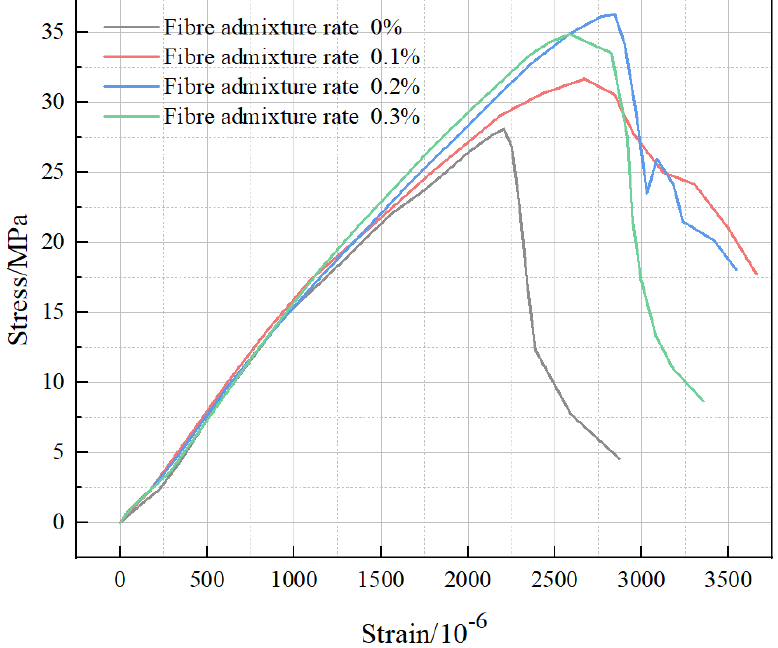
Figure 11. Effect of fiber admixture on BFRC stress–strain curves (freeze–thaw cycles from room temperature to − 150 °C).